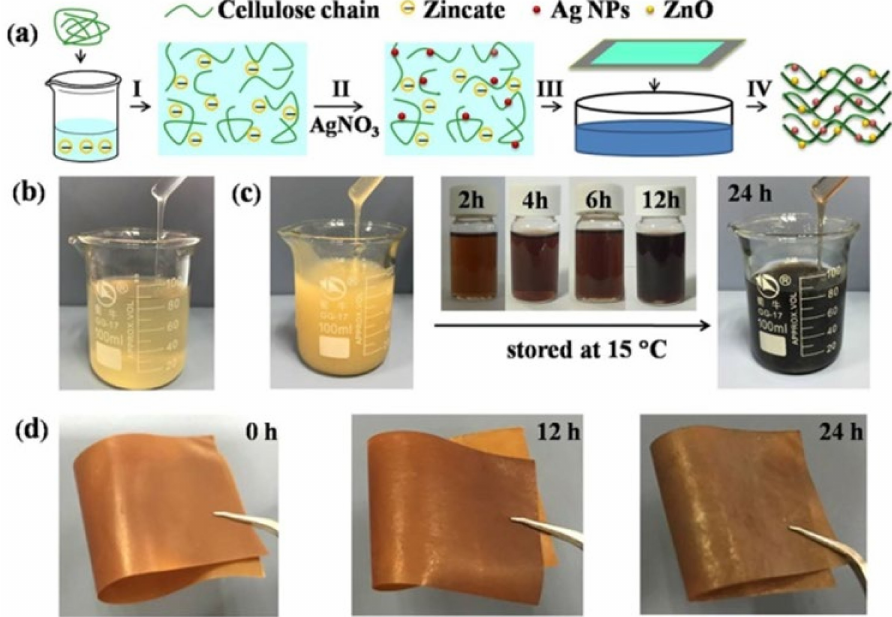
Figure 4. ( a ) Preparation of the Ag/ZnO decorated cellulose nanocomposite films: (I) cellulose dissolving in aqueous NaOH/urea/zincate solution, (II) Ag + reduction in cellulose dope, (III) casting and coagulation of films, (IV) the produced nanocomposite film. ( b ) Photographs of dissolved cellu- lose dope, ( c ) after different storage time, mixing of AgNO 3 − cellulose dope system, and ( d ) resultant nanocomposite films [88]. Copyright © 2018, American Chemical